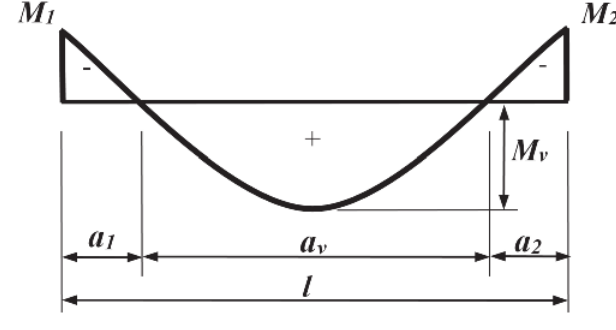
Figure 1 Parameters utilized to calculate the equivalent stiffness in a span of a continuous beam using Equation